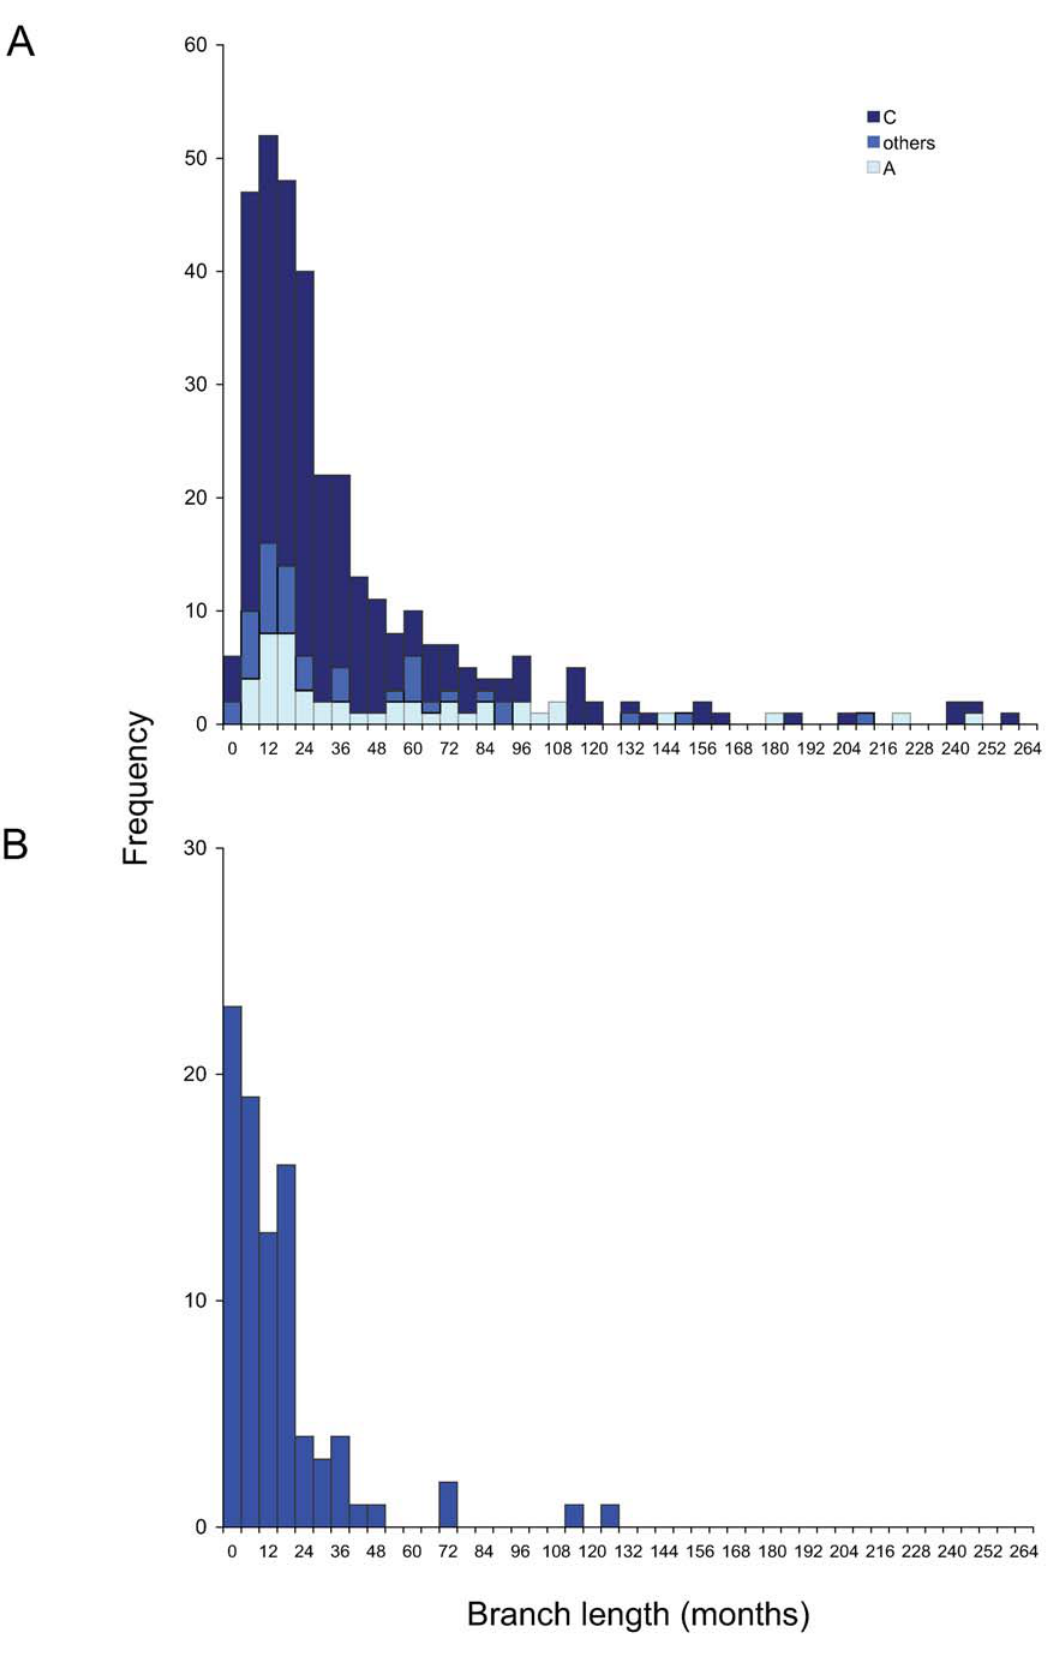
Figure 4. Histogram of internal branch lengths from time-scaled trees representing minimum transmission intervals . A) Non-B subtype UK transmission clusters, as defined in the text. B) Subtype B transmission clusters from MSM in London [12].